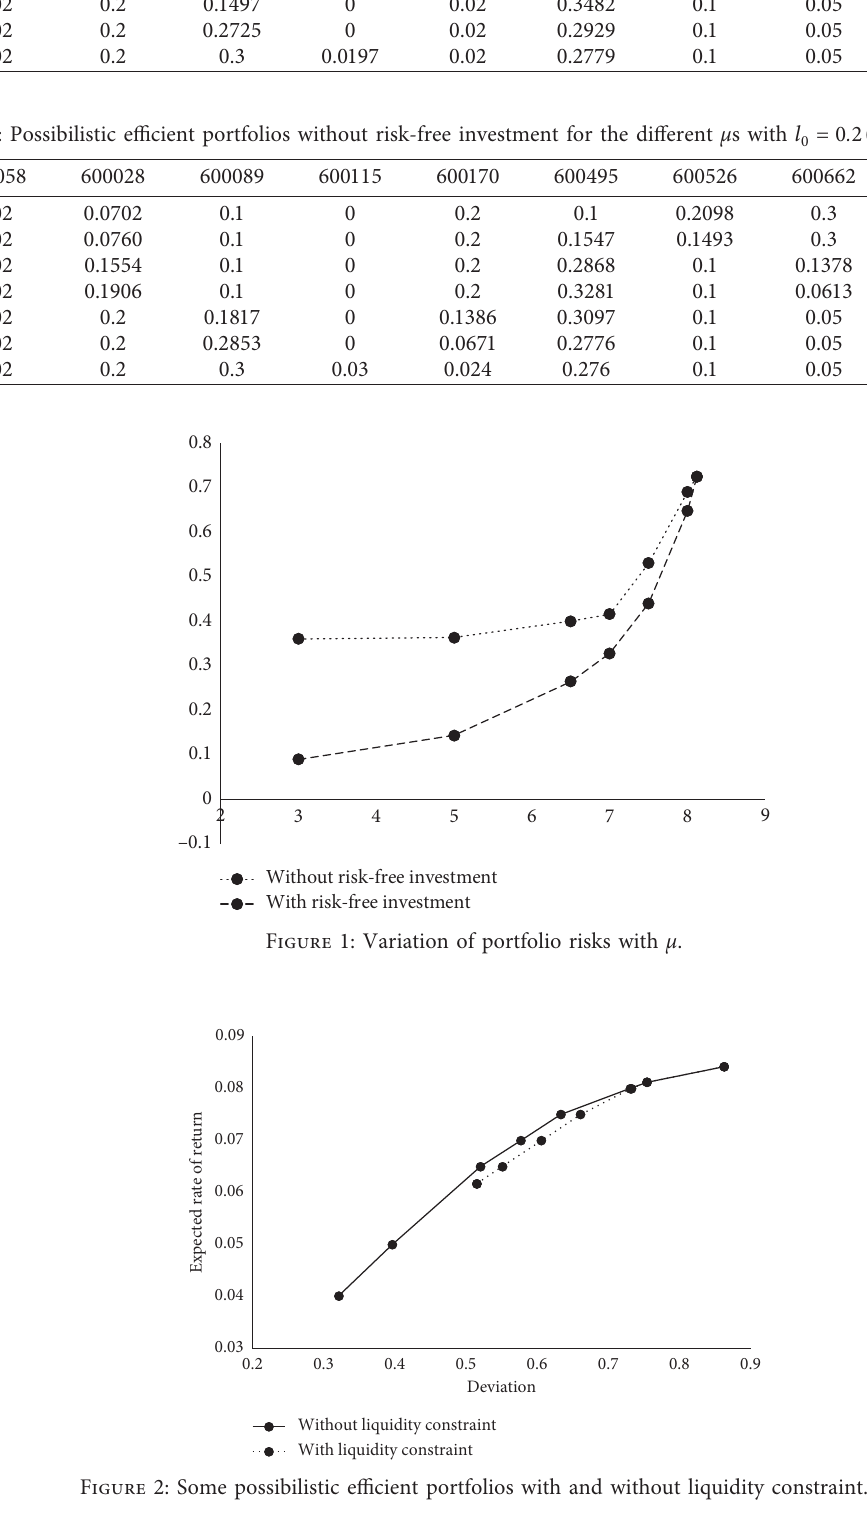
Table 3: Possibilistic efficient portfolios with risk-free investment for the different µ s with l